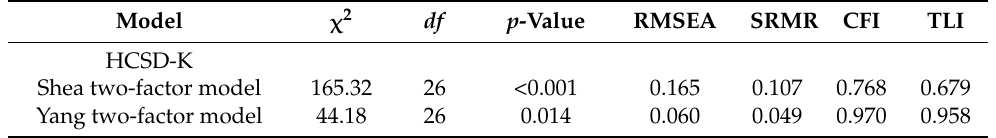
Table 2. Comparisons of model fit for the Korean version of the Health Care System Distrust scale. Model χ 2 df p -Value RMSEA TLI HCSD-K Shea two-factor model 165.32